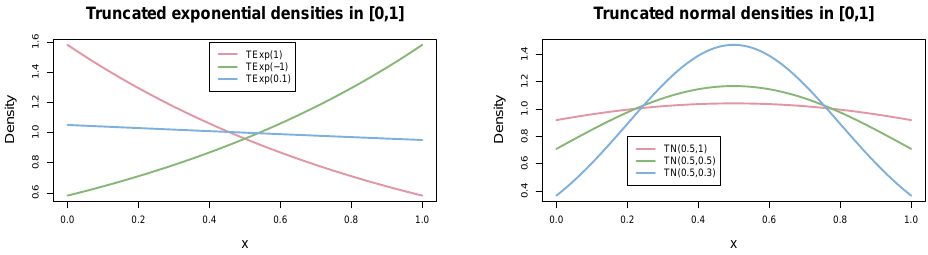
Figure 2. Density functions of the truncated exponential and the truncated normal distributions, respectively, for different values of their